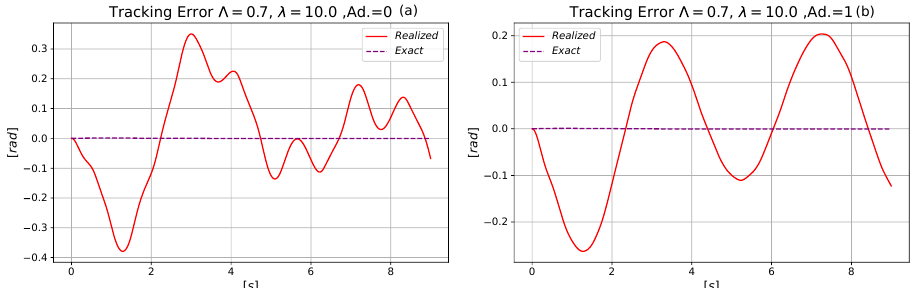
Figure 5. Trajectory tracking error for the maximal amplitude and circular frequency of the nominal trajectory for which the adaptive controller was able to use only the originally learned data. ( a ): Non- adaptive, ( b ): adaptive